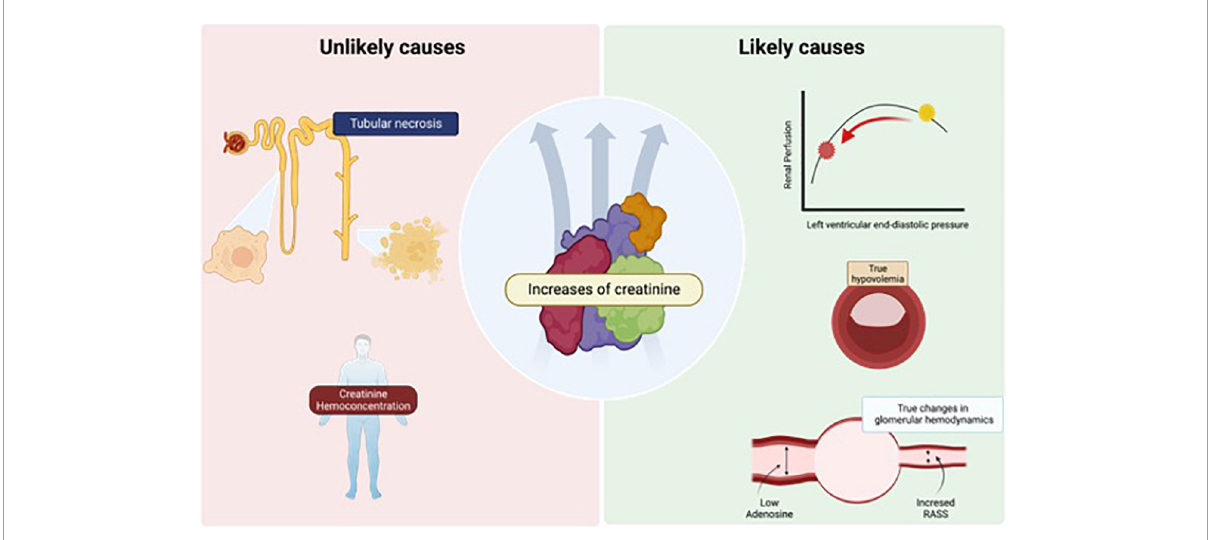
FIGURE2 Different trajectories of serum creatinine (sCr) during decongestion in cardiorenal syndrome 1. During effective decongestion in acute decompensated heart failure (ADHF), the increase in sCr < 0.5 mg/dL has been considered acceptable, and is associated with fewer major cardiorenal events, this arbitrary number seems to be inconsistent with reality, where even greater increases in sCr could be associated with the same benefit, but there could be patients whose values have negative connotations and reflect a worsening of kidney function that exceeds the benefit of decongestion. The image was licensed from